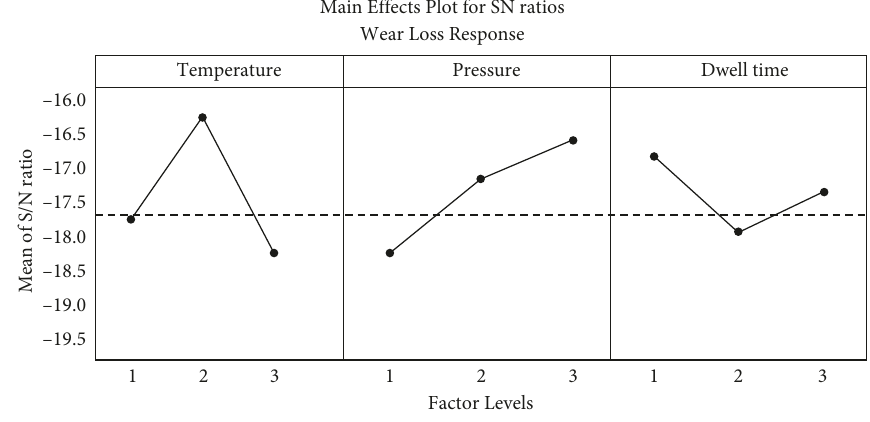
Figure 8: Main effect plot for wear loss responses.